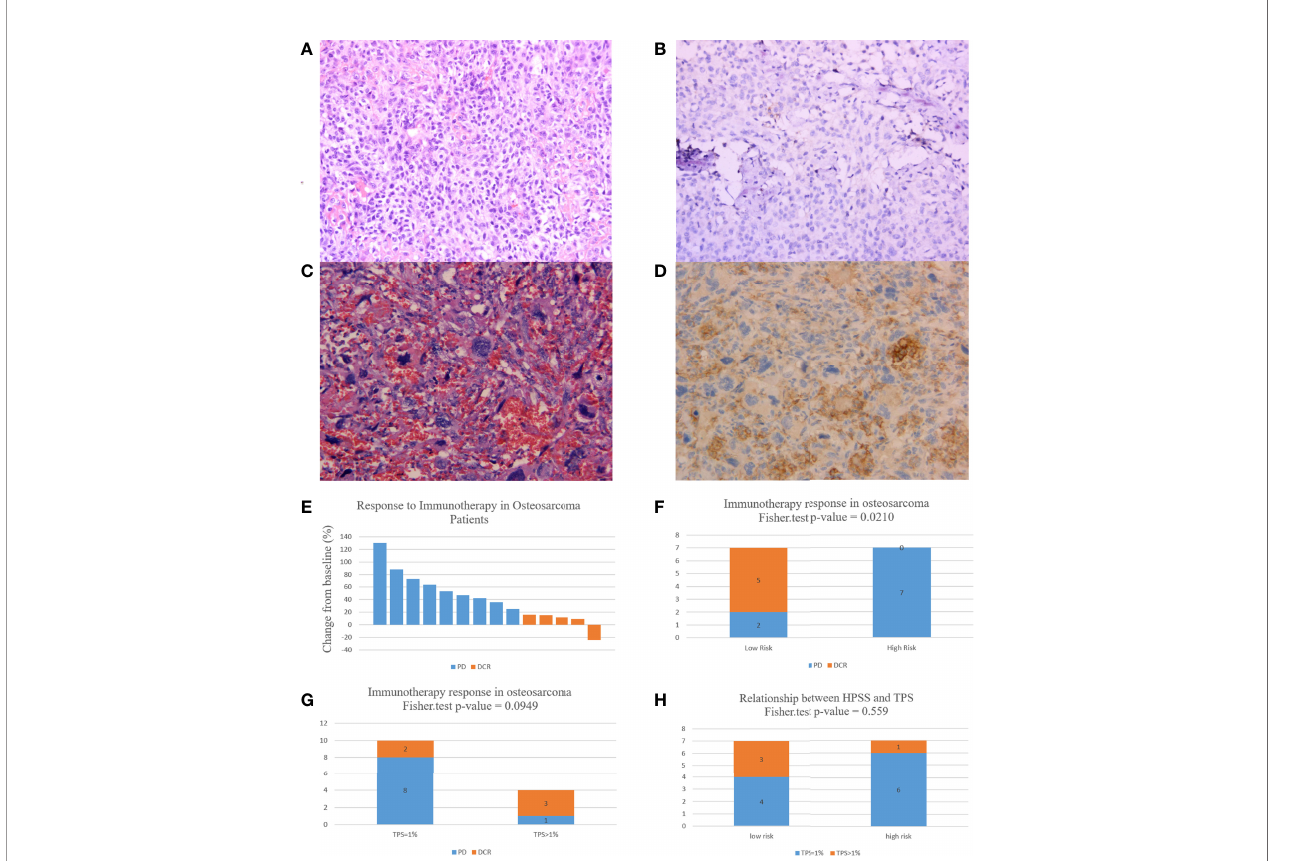
FIGURE 7 | HPSS can predict patient response to immunotherapy to a certain extent. (A) HE staining of a patient with 3% TPS expression; (B) PD-L1 expression in a patient with a TPS expression of 3; (C) HE staining of a patient with 8% TPS expression; (D) PD-L1 expression in a patient with a TPS expression of 8; (E) A waterfall plot of the response to immunotherapy in 14 osteosarcoma patients; (F) Histogram showing differences in immunotherapy status in HPSS risk groups; (G) Histogram showing differences in immunotherapy status in different TPS groups; (H) Differences in TPS values in different HPSS risk